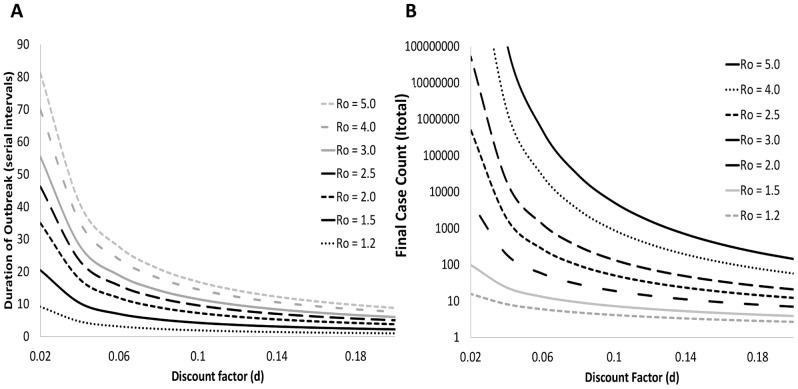
Model behaviour.The overall behaviour of the IDEA model based on a range of possible Ro and d values (a) the variation of tmax or outbreak duration as a function of Ro and d (b) the variation of Itotal or the final cumulative incidence as a function of R0 and d.